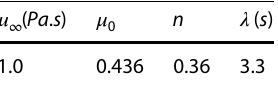
Table 2 Numerical values for the carreau model [14]